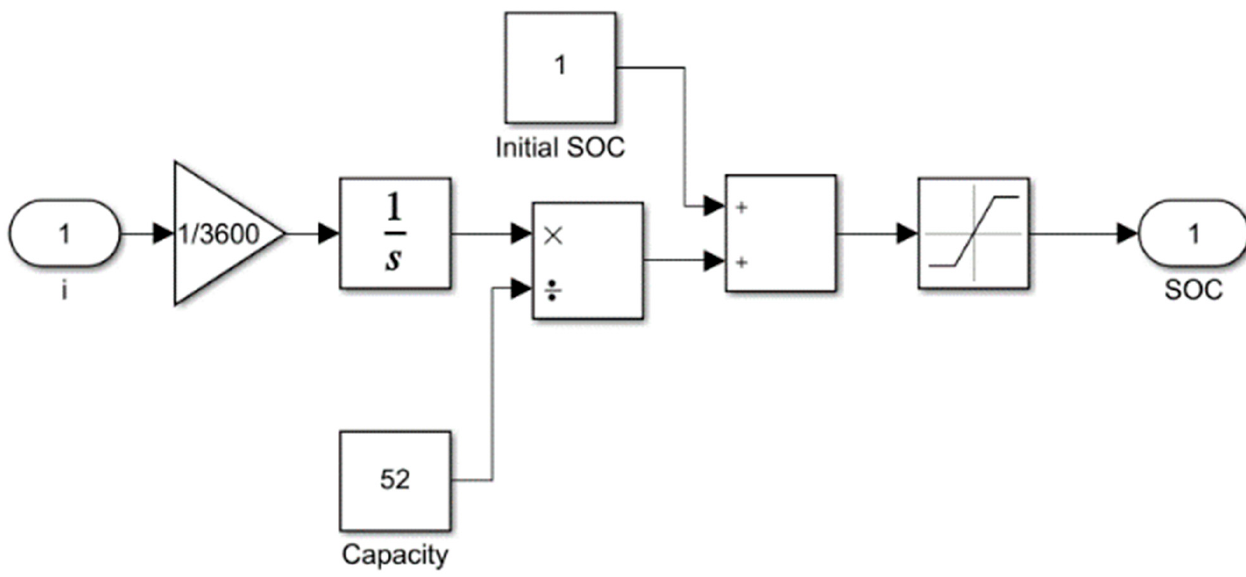
Figure 4. Simulation model for the SOC calculation.